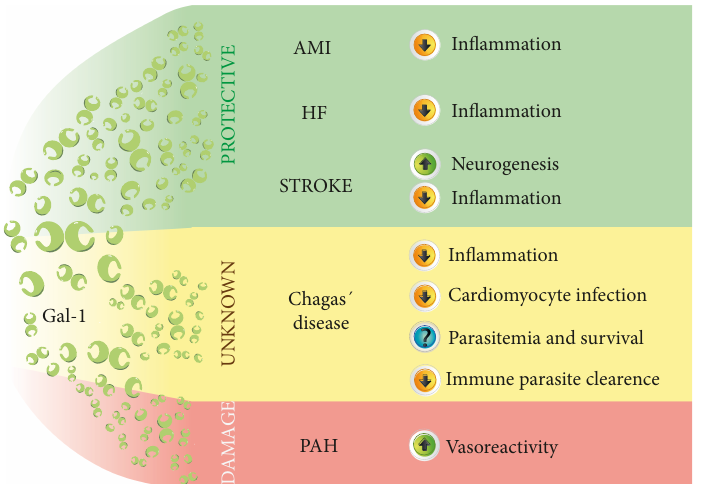
Figure 2: Proposed roles of Gal-1 in cardiovascular disease. Galectin-1 (Gal-1) has been implicated in a number of cardiovascular disorders. The roles of this lectin vary according to di ff erent clinical contexts. Gal-1=galectin-1; AMI=acute myocardial infarction; HF =heart failure; PAH=pulmonary arterial